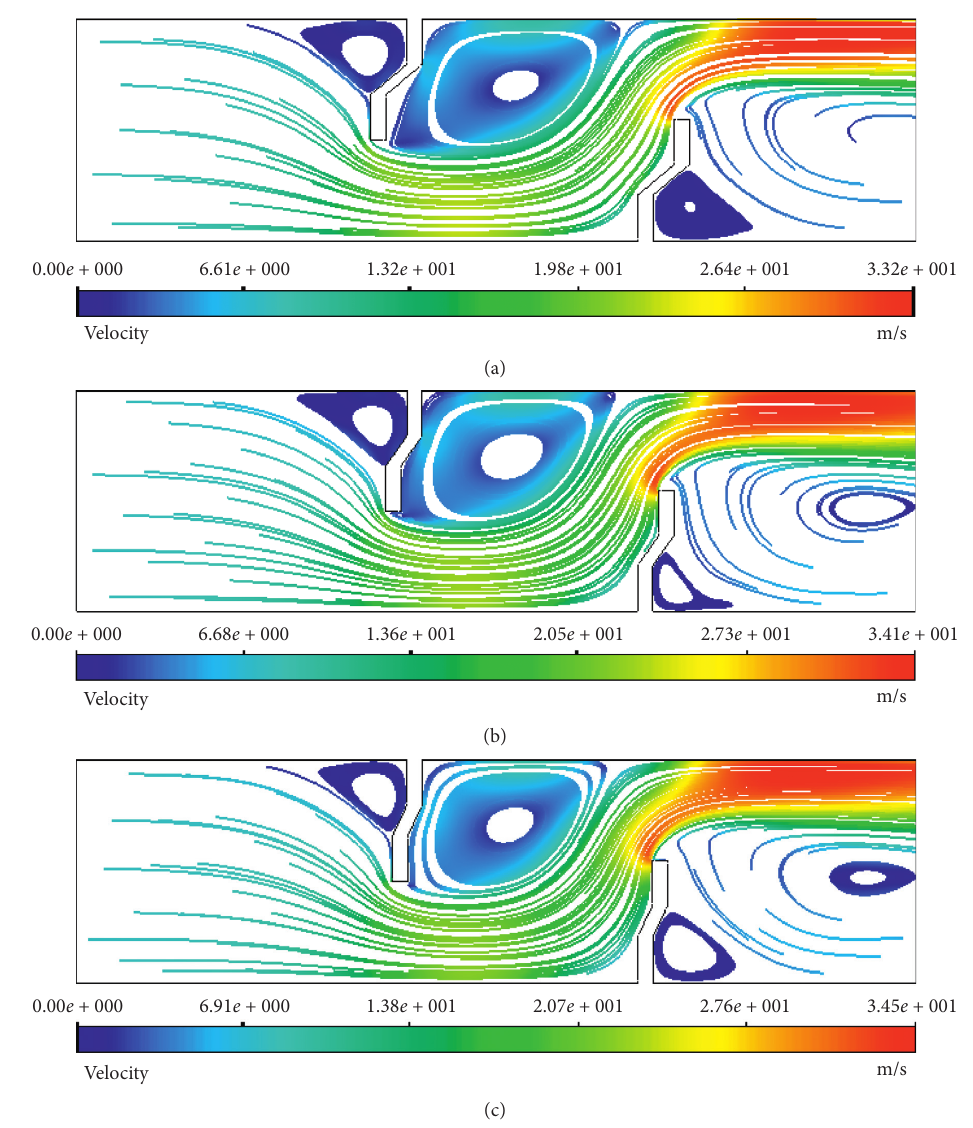
Figure 4: Streamlines for different values of inclination angles: (a) φ